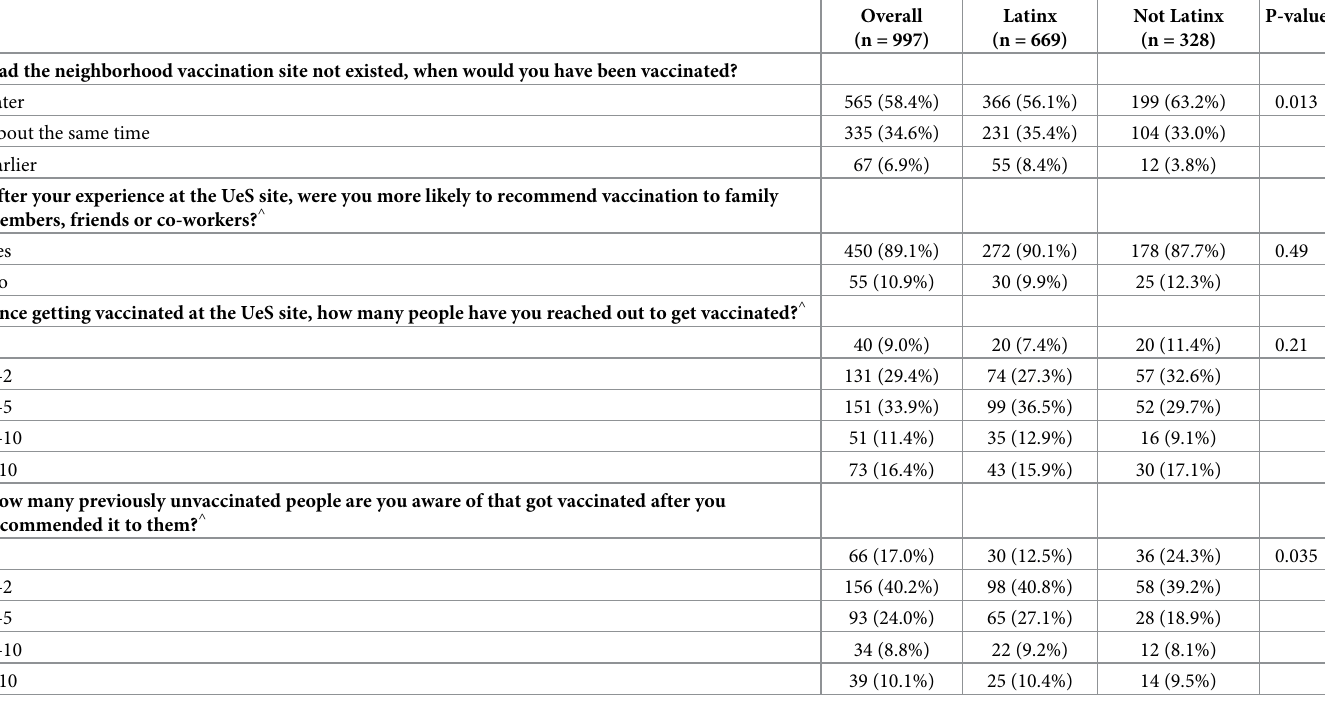
Table 5. Behavior change outcomes associated with the effectiveness of the “Motivate, Vaccinate and Activate”